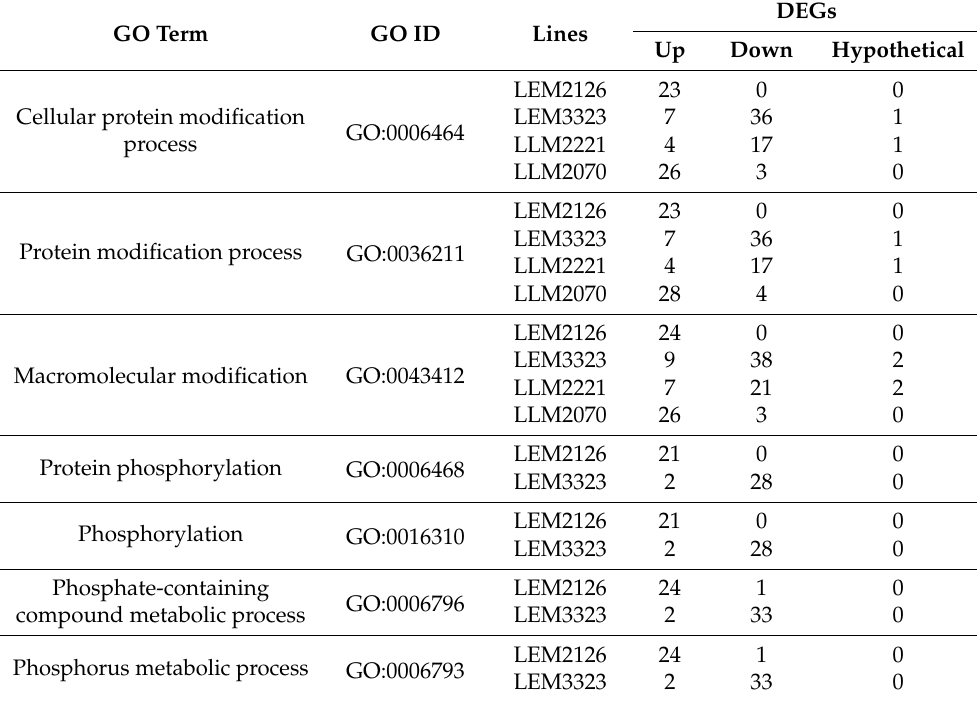
Table 1. Common GO-enriched terms of DEGs for the biological process category in several lines of L. infantum . DEGs GO Term GO ID Lines Up Down Hypothetical LEM2126 Cellular protein modification GO:0006464 process